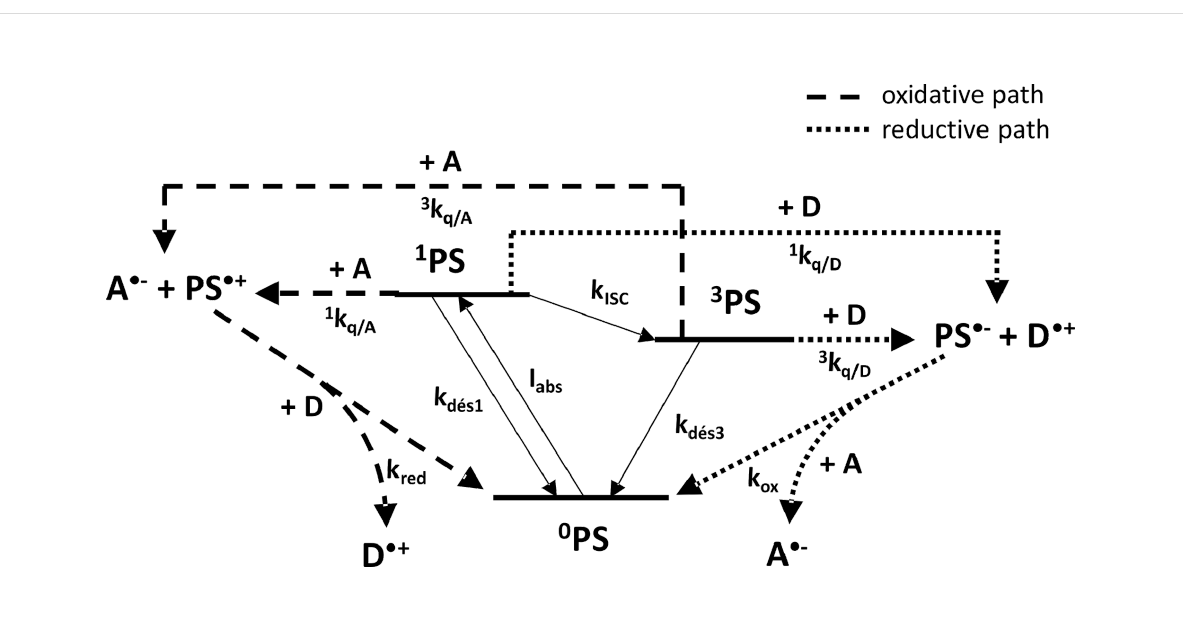
Figure 3: Mechanistic description of photocyclic system involved in the RB/TA/EDB system. The rate constants are defined in the text.